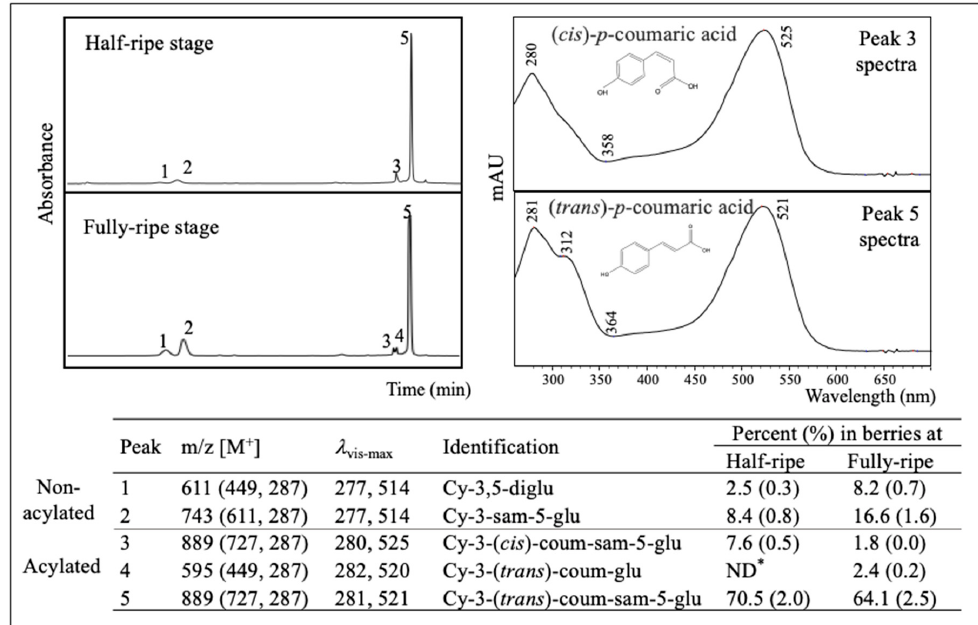
Figure 2. HPLC chromatograms of half and full-ripe ‘Nova’ extracts detected at 520 nm, their peak identifications, and quantifications, and the UV-Vis spectra of peaks 3 and 5. Cy: Cyanidin; glu: glucoside; sam: sambubioside; coum: coumaroyl. *ND: Not detected.